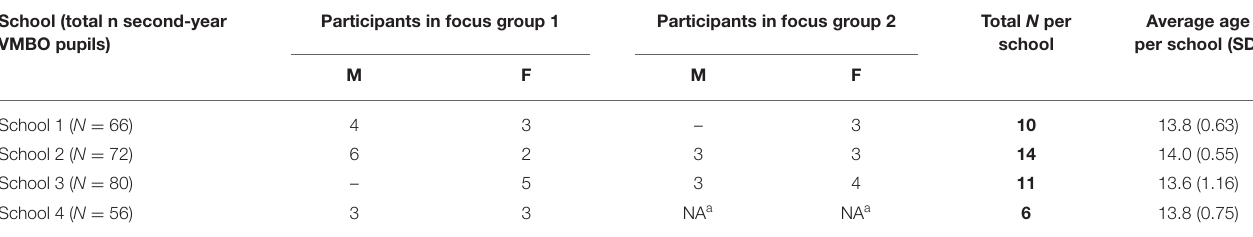
TABLE 2 | Pupil characterics per school ( n =